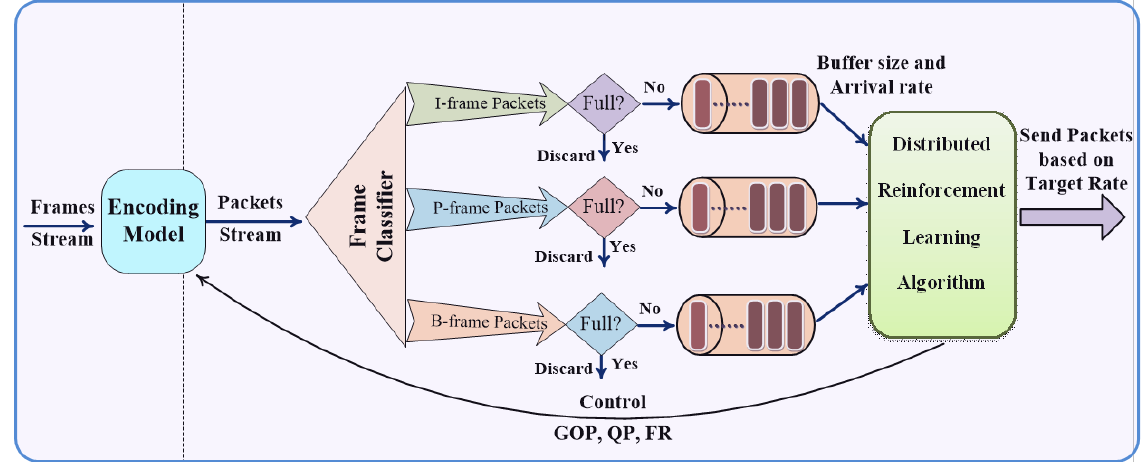
Figure 4. Block Diagram of the Proposed Traffic Shaping.